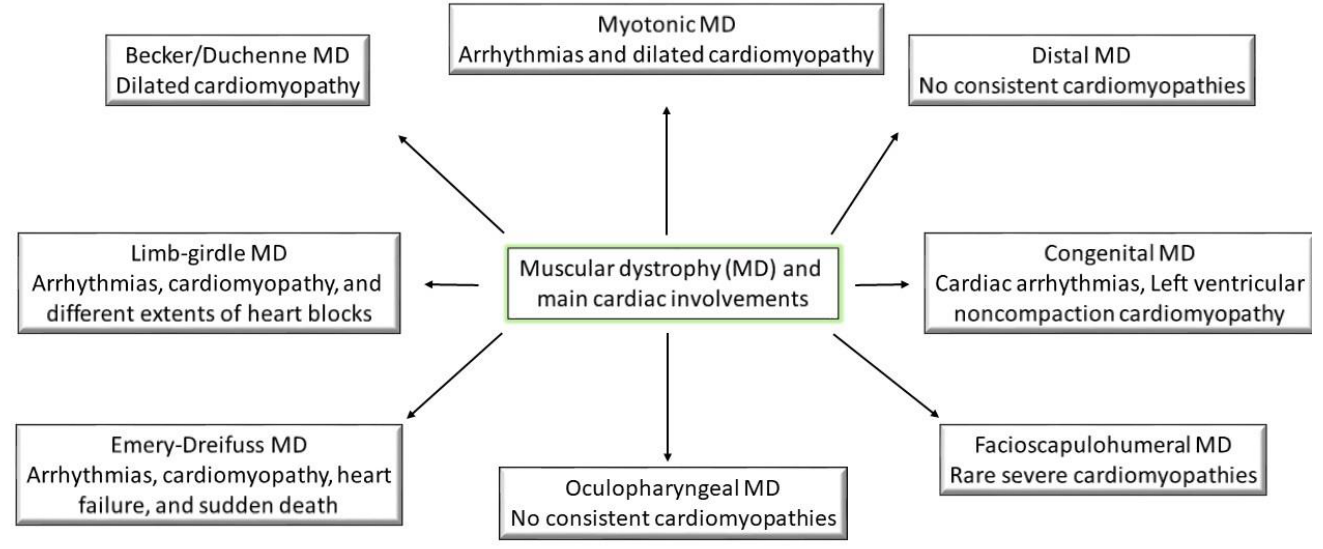
Figure 1. Muscular dystrophies and their primary affected proteins and muscles; (MD — muscular dystrophy).